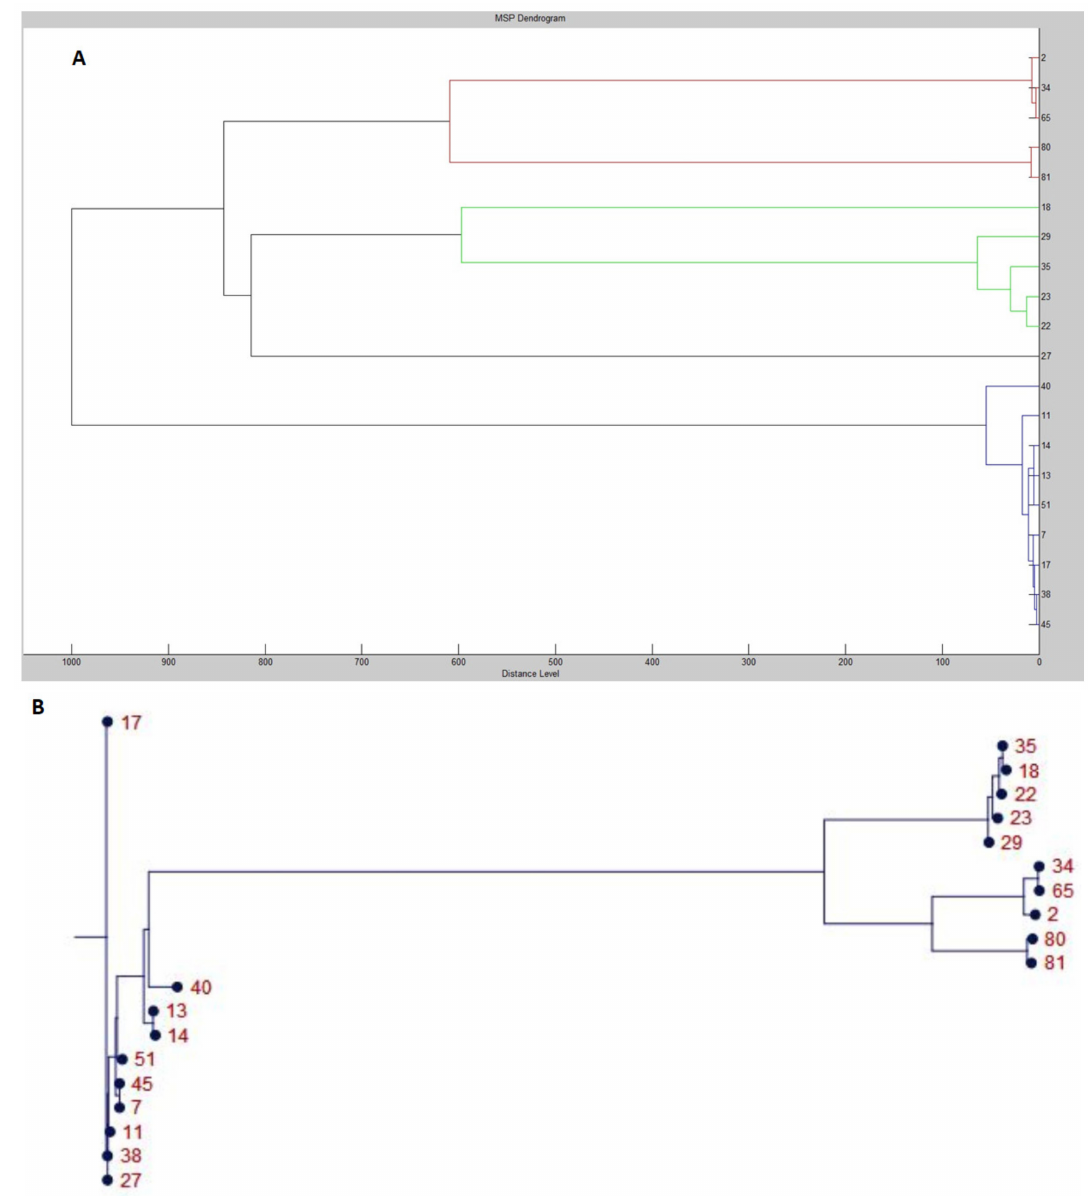
Figure 1. An example comparison of phylograms derived from MALI-TOF MS Biotyper ( A ) and 16S rDNA ( B )